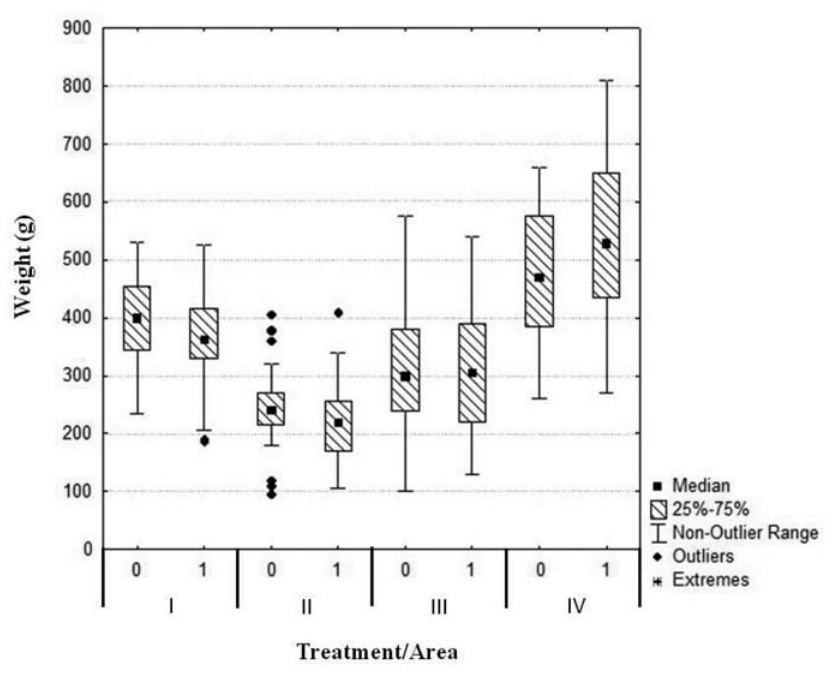
Fig. 2. Boxplots indicating the distribution of weights of eggplants collected for analyses. It is possible to visualize that within the same area no significant differences were found between the free visitation test (0) and pollen complementation test (1). However, a significant variation in the weight of eggplants was found when (1) was compared among areas I, II, III and